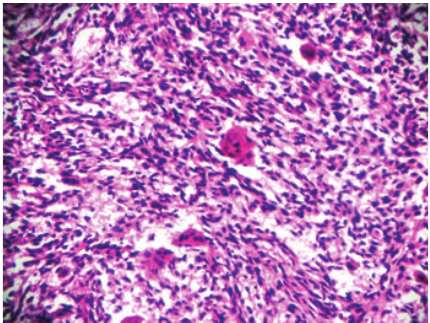
Figure 2: Histopathology of the tumor confirming GCT.